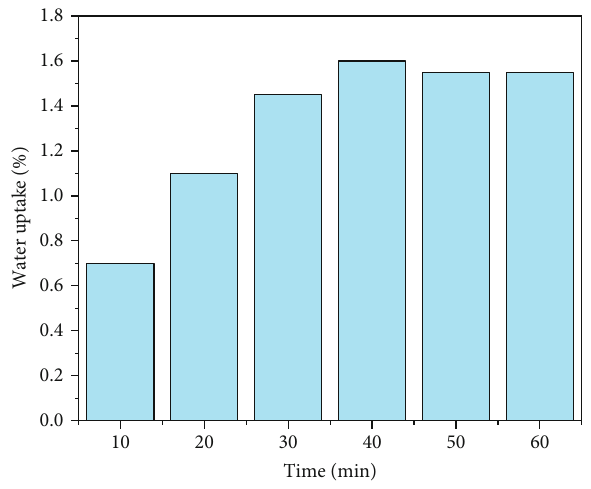
Figure 3: Water uptake % of fabric/PE